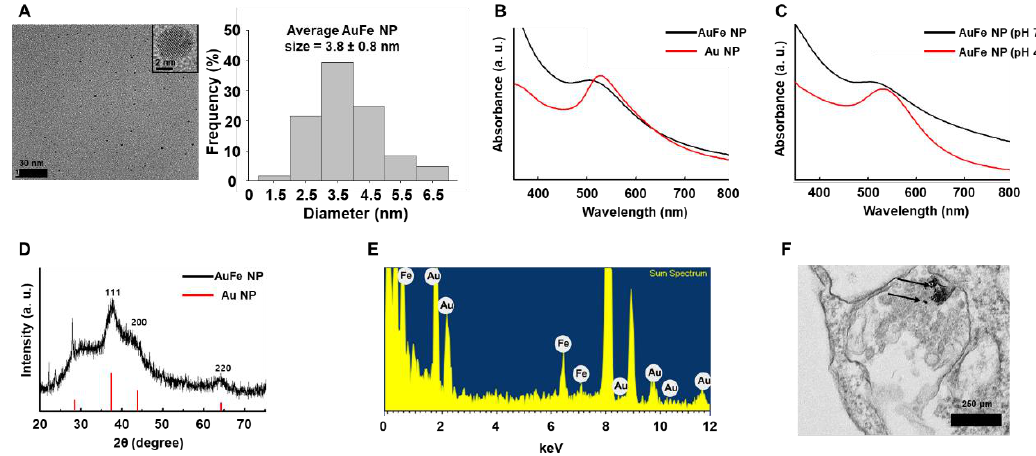
Figure 1. ( A ) Transmission electron microscopy (TEM) image of AuFe NPs (left) with size distribution (right). UV-Vis spectra of AuFe NPs with Au NPs at ( B ) neutral pH 7.0 and ( C ) pH 4.5. Black line indicates AuFe NP and red line indicates Au NP. ( D ) Powder X-ray diffraction (XRD) patterns of AuFe NPs and Au NPs. ( E ) Energy-dispersive X-ray spectroscopy (EDS) spectrum of AuFe NPs. ( F ) TEM image of an hMSC with AuFe NPs (black arrows: AuFe NPs in hMSC, scale bar represents 250 μm).